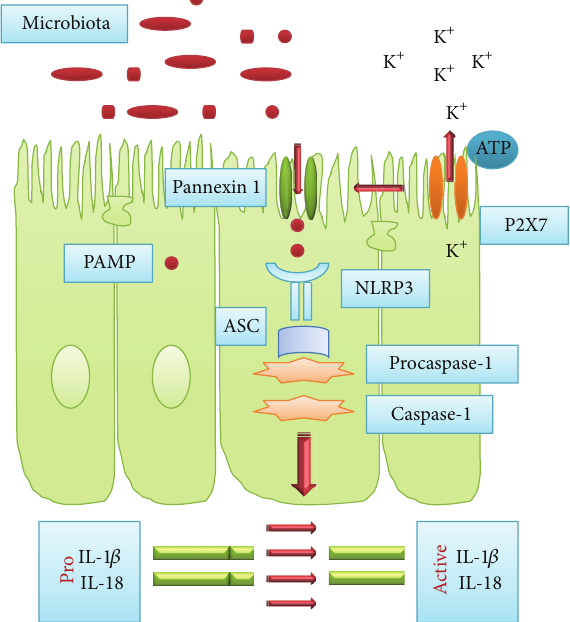
Figure 1: Inflammasome components, assembly, and activation. Microbial and nonmicrobial stimuli can induce the activation of the NLRP3 inflammasome. The NLRP3 inflammasome consists of a nucleotide-binding-oligomerization-domain- (NOD-) like receptor (NLR) that can be activated by certain bacterial toxins containing specific pathogen-associated molecular patterns (PAMPs), in the presence of extracellular adenosine triphosphate (ATP). Oligomer- ization of the NLR and ASC results in a macromolecular complex capable of cleaving procaspase-1 to its active form, which in turn cleaves the proforms of IL-1 𝛽 and IL-18 to their biologically active